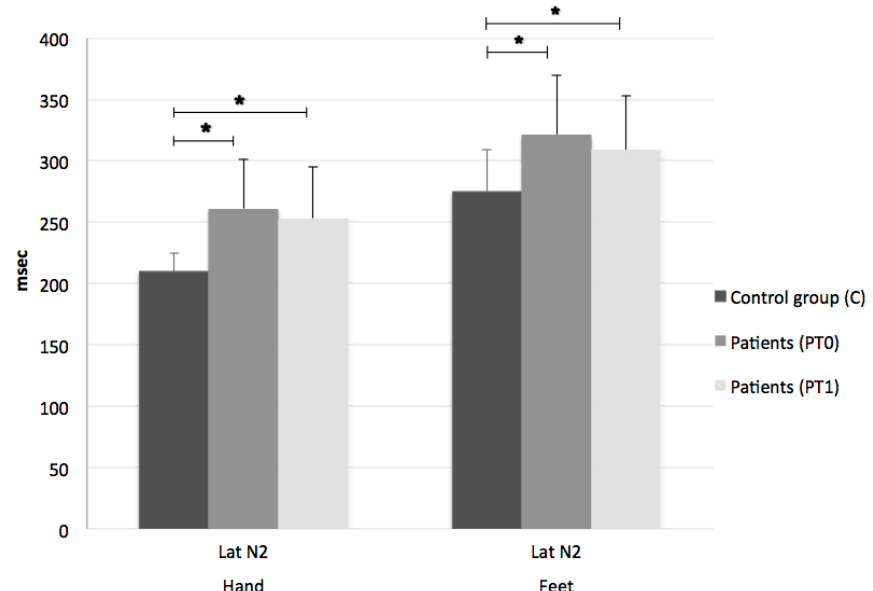
Figure 2. Laser-evoked potentials’ mean N2 latencies for dominant hand and feet in control group (C) and patients before (PT0) and after (PT1) Sativex ® . N2 latencies in MS patients are significantly reduced in both dominant hand and feet compared to controls. No changes are observed after